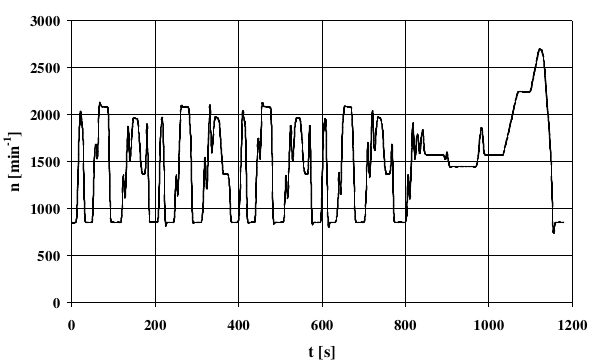
Fig. 5. The relative torque characteristic in the Malta test